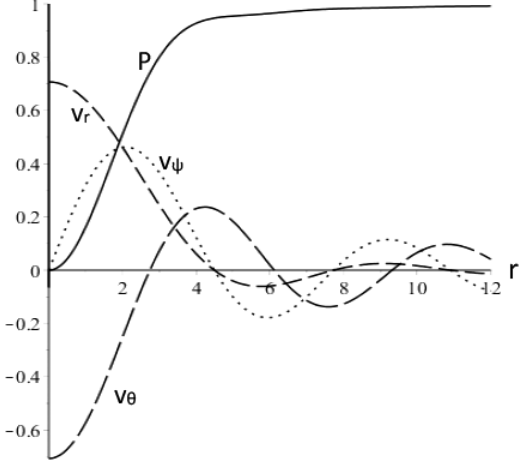
Fig. 14. Velocity and pressure of the ¯rst-order spherical solution ( n ¼ 1 , (cid:2) ¼ (cid:9)= 2 ). The three velocity components and pressure (along the radius, in the (cid:2) ¼ (cid:9)= 2 plane) are shown in Fig. 14.